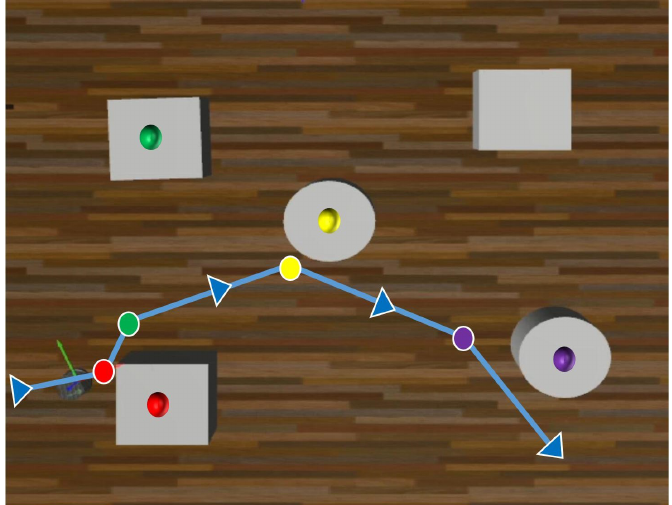
Figure 9. Trajectory of obstacle avoidance in simulation. The blue line with arrow is the trajectory, and the colored points in the trajectory are the places where the avoidances of correspondent colored obstacles